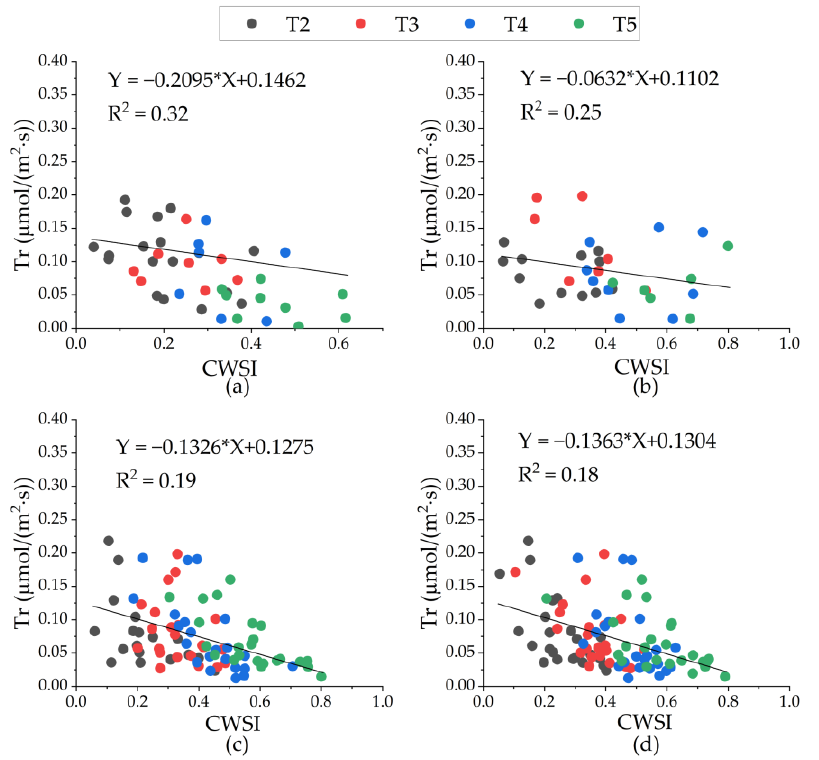
Figure 14. Relationship between the Tr and the CWSI based on the ( a ) measured and ( b ) predicted baseline values of E1 and the CWSI based on the ( c ) measured and ( d ) predicted T wet and T dry of E2.